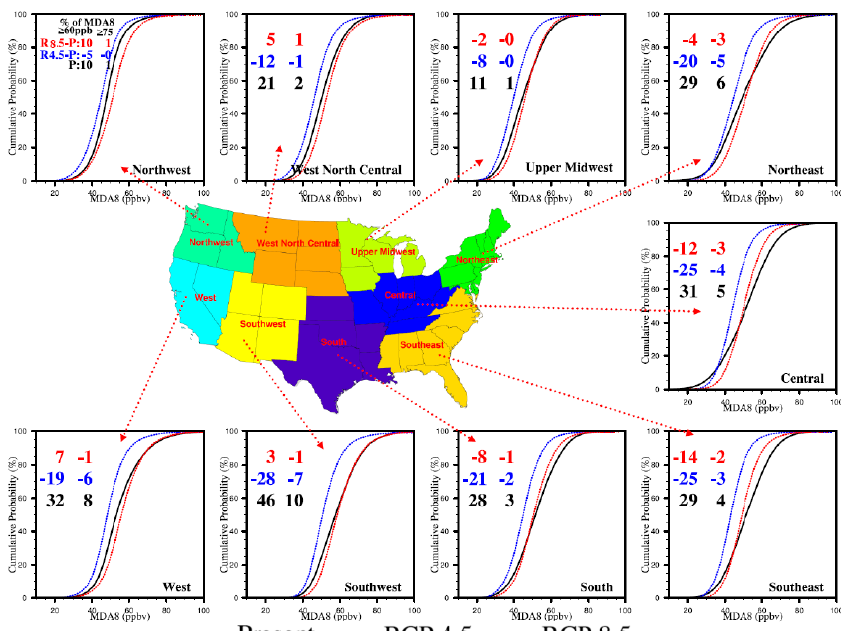
Fig. 6. Cumulative distributions of MDA8 ozone from CMAQ. The black, blue and red colors represent the distributions of MDA8 at present climate (2001–2004), RCP 4.5 (2057–2059) and RCP 8.5 (2057–2059), respectively. There are two columns of numbers: the numbers on the left show the percentage of MDA8 ozone exceeding 60ppbv at present, the percentage change in RCP 4.5 (blue) and RCP 8.5 (red) compared with present; the numbers on the right are similar as left but for MDA8 ozone exceeding 75